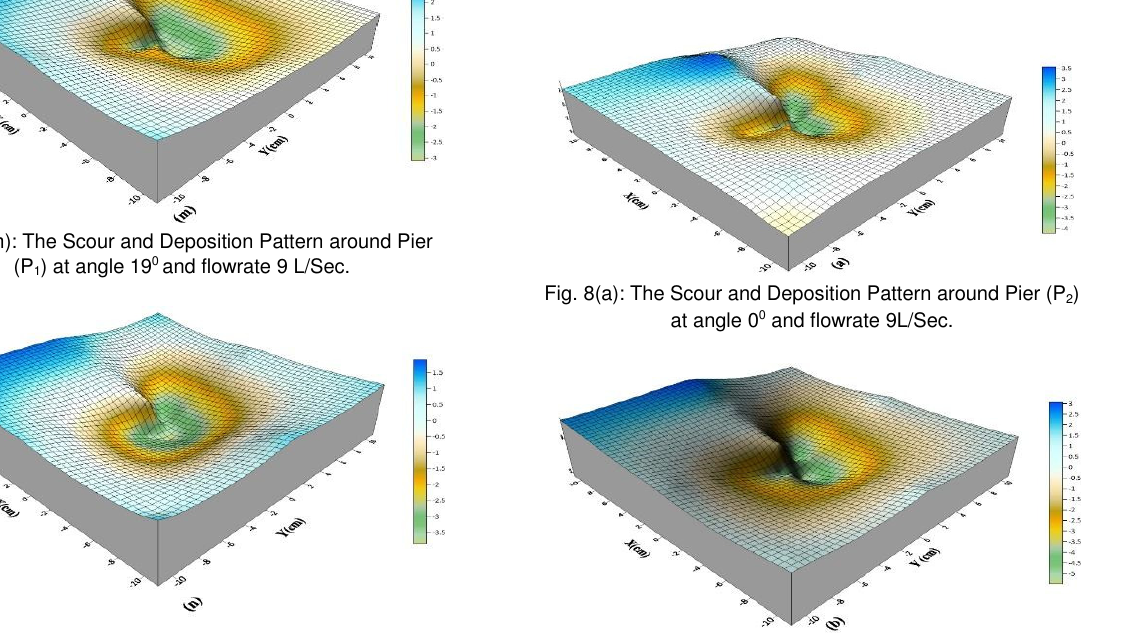
Downstream Pier with Angle of Inclination Fig. 8 represents the variation of scouring pattern around downstream pier at angle of inclination 0˚,7˚,12˚,15˚ and 19˚ and flow rate 9,14, and 18 L/sec respectively. The scour area and depth are greater in case of 0˚ as shown in Fig. 8(a-c) while it decreases as angle of inclination is increased to 7˚ and 12˚ as shown in Fig. 8(d-i). The scour area and depth become minimum at angle of inclination 19˚ as shown in Fig. 8(m-o). In case of downstream pier deposition occurred at downstream side of pier(P 2) because the scouring material form (P 1 ) is transported to downstream side of pier (P 2 ) .